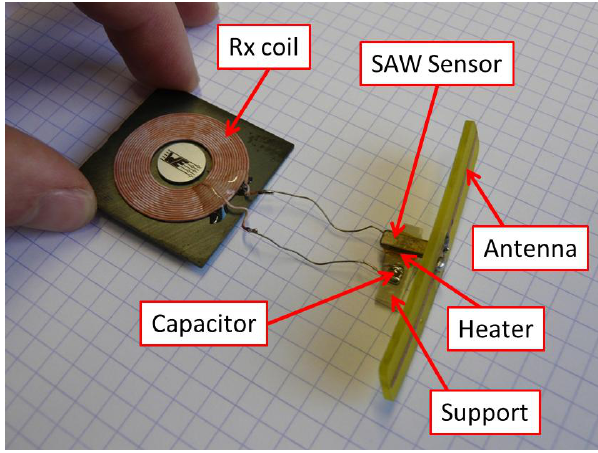
Figure 1. The WiPirani prototype, made of a SAW Tag with its antenna, a planar coil designed for inductive power transfer and a heating resistor. The resistor is located between the SAW Tag and its PCB support. It is not visible on the picture. The underlying grid is made of 0.5 mm × 0.5 mm squares.